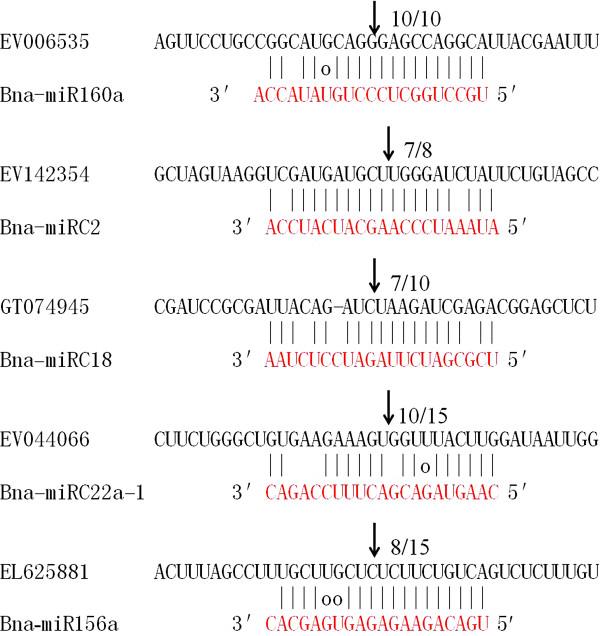
Mapping of the mRNA cleavage sites by RNA ligase-mediated 5′RACE. Each top strand (black) depicts a miRNA complementary site, and each bottom strand depicts the miRNA (red). Watson-Crick pairing (vertical dashes) and G:U wobble pairing (circles) are indicated. The arrows indicate the 5′ termini of mRNA fragments isolated from B. napus, as identified by cloned 5′ RACE products, with the frequency of clones with the predicted cleavage site shown.